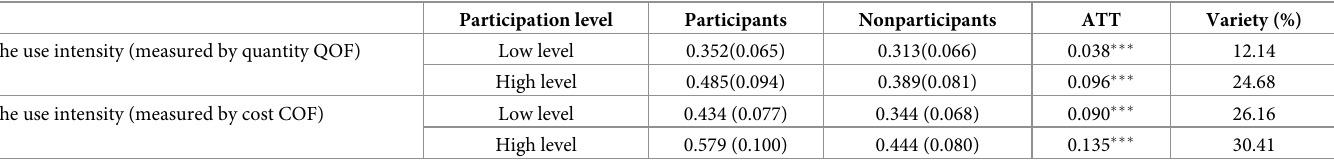
Table 6. Results of the heterogeneity analysis.